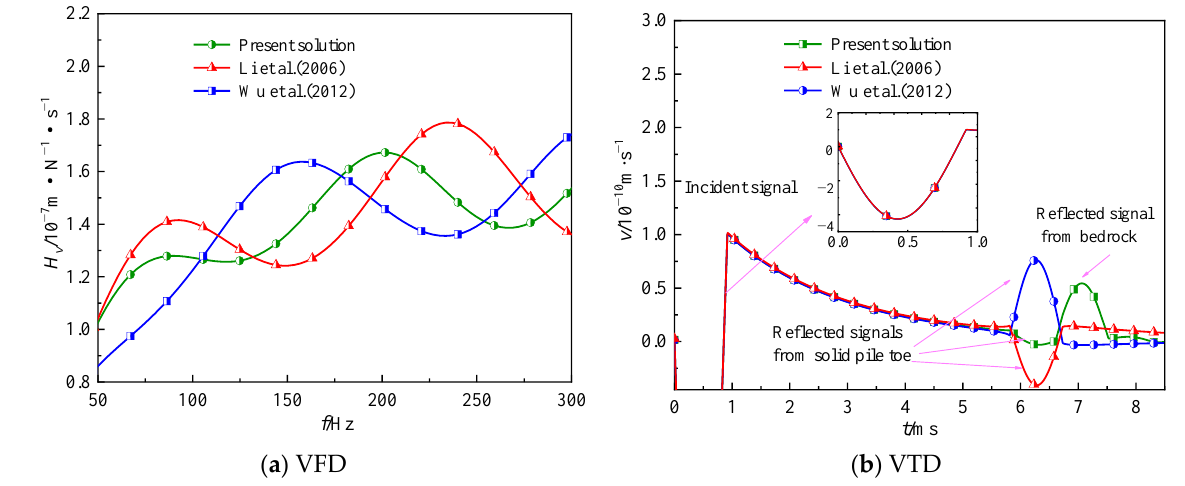
Figure 4. Comparison between the proposed and existing solutions [31,37].